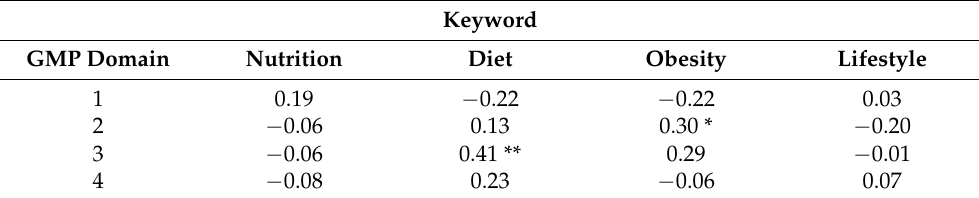
Table 3. Associations between keywords and Good Medical Practice (GMP) Domains across